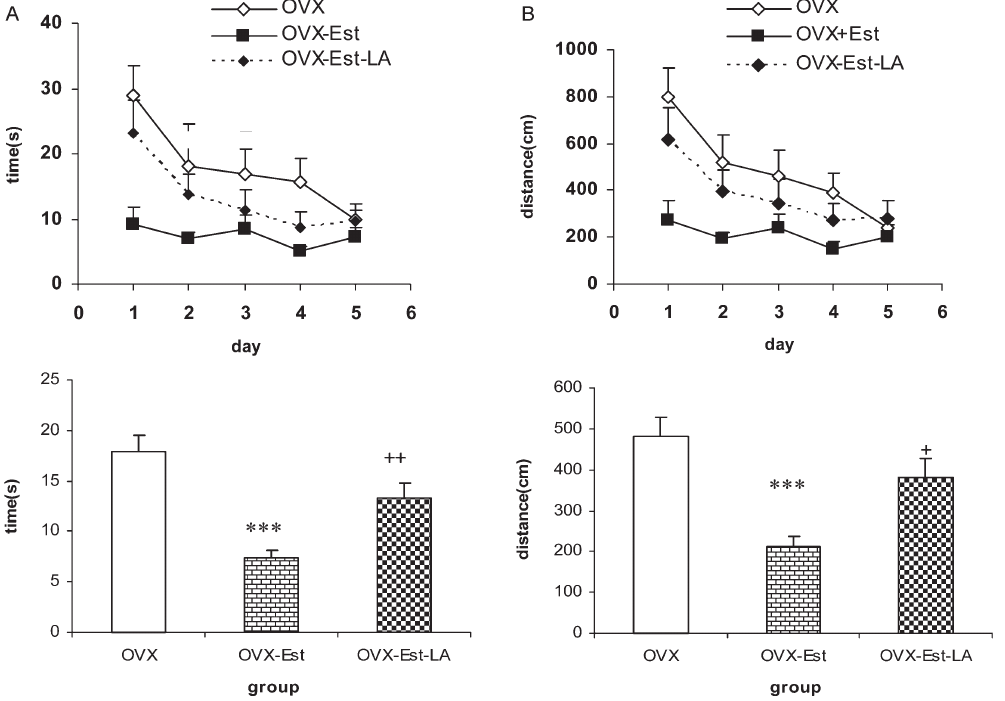
Figure 2 - Comparison of time latency (A) and path length (B) among OVX, OVX-Est and OVX-Est-LA groups. Data are presented as mean ¡ SEM. (n=8 in each group). *** P , 0.001 compared to OVX group, + P , 0.05, ++ P , 0.01 compared to OVX-Est group. The upper portion of the figure compares groups’ total time latency or traveled path length over five days, and the lower portion of each figure is the comparison of time latency or traveled path length each day between groups.